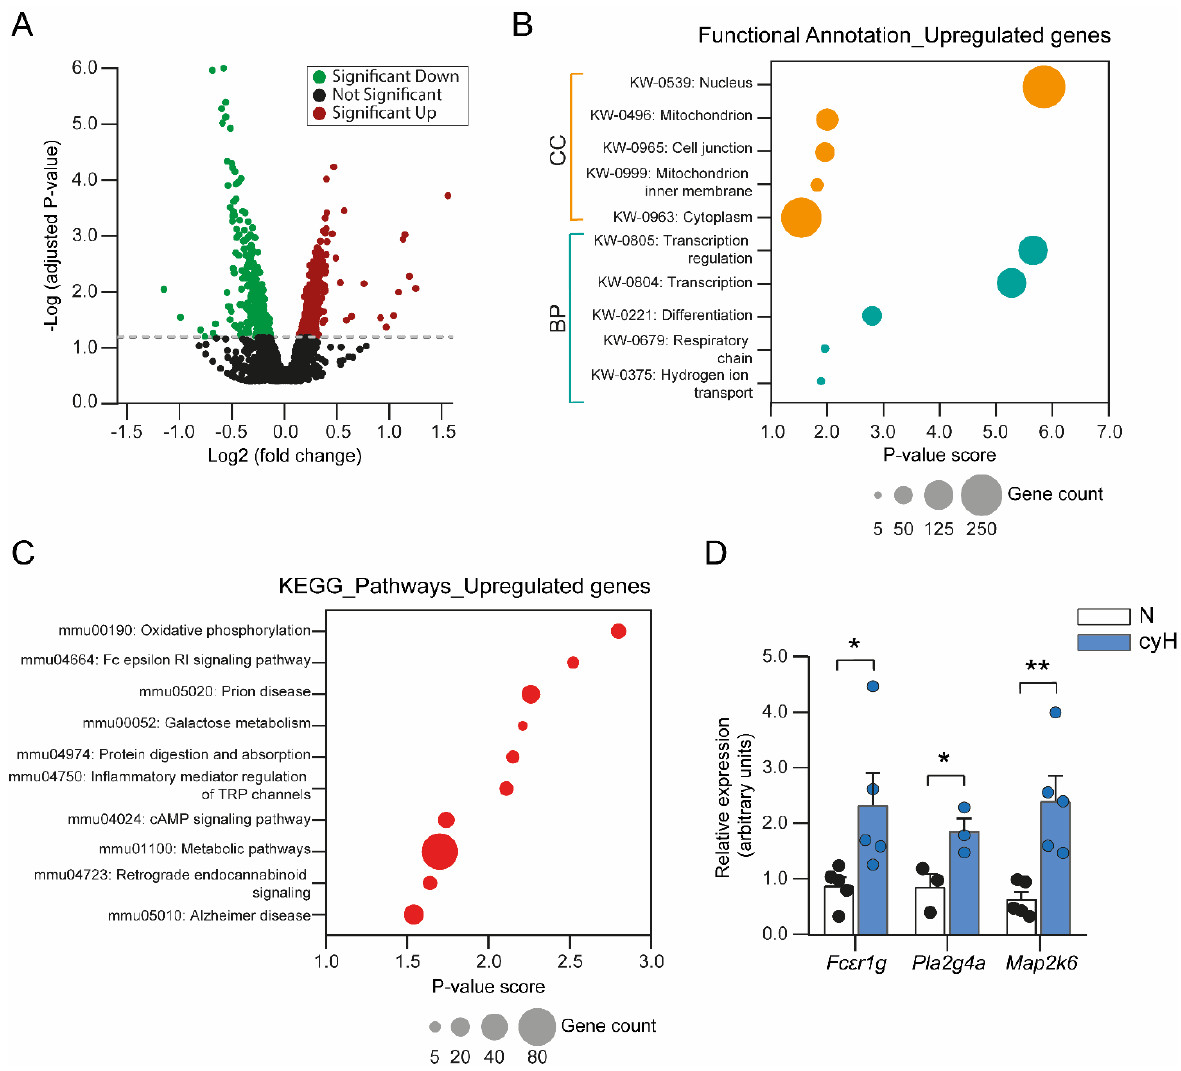
Figure 3. Transcriptional signature of BMMCs exposed to cyclic hypoxia is related to oxidative phosphorylation and the Fc ε RI signaling pathway. ( A ) Volcano plot of DEGs in BMMCs exposed to cyH. Green dots, downregulated genes; red dots, upregulated genes. ( B ) Functional annotation of upregulated genes in BMMCs subjected to cyH. Enrichment of biological processes (BP) and cellular components (CC) along with the number of genes associated with each functional category. ( C ) Enrichment map of the top ten enriched upregulated pathways in cyH conditions. The number of DEGs associated with each pathway is illustrated according to the size of the circle. ( D ) Two million BMMCs were exposed to N (2.5 h at 21% O 2 ) or cyH (H2) and real-time quantitative PCR was performed to validate the overexpression of some DEGs associated with the Fc ε RI signaling pathway. Unpaired t -test, * p < 0.05, and ** p < 0.01 versus N, n = 3–5 experiments for each condition using different BMMCs cultures. Table 1. Functional enrichment analysis of cyclic hypoxia-related mast cell signature genes.